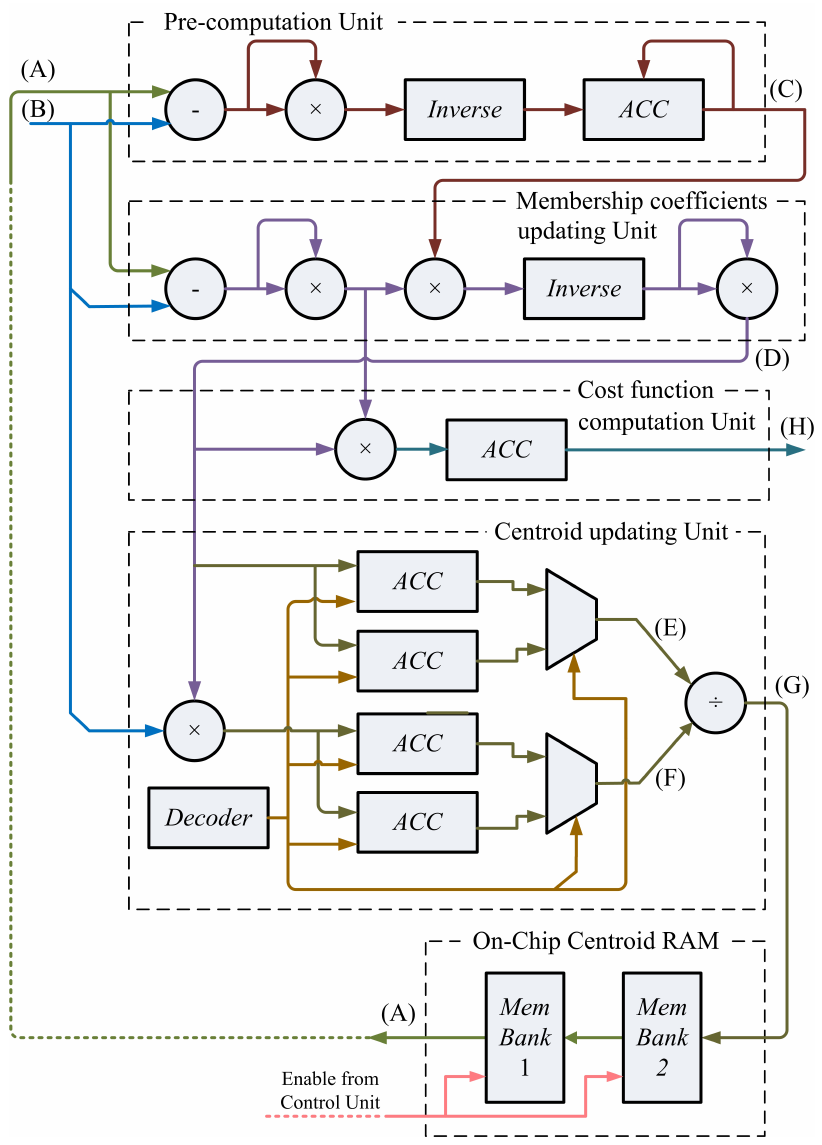
Figure 8. The fuzzy C-means (FCM) circuit for c = 2 .